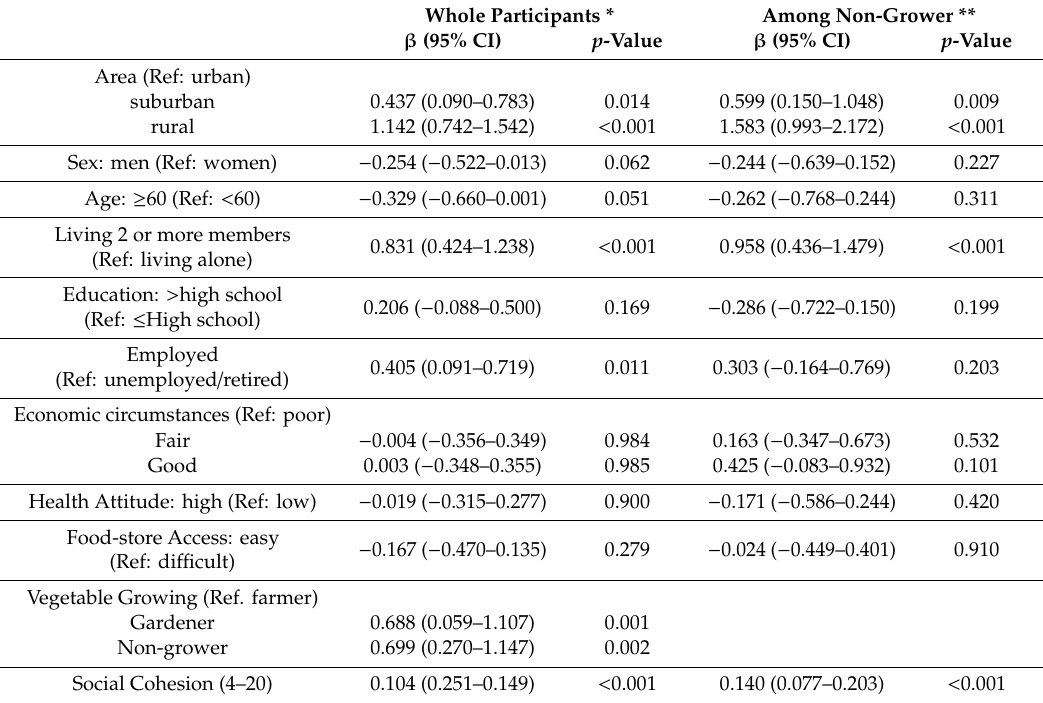
Table 2. Relationship with vegetable receiving frequency (Survey